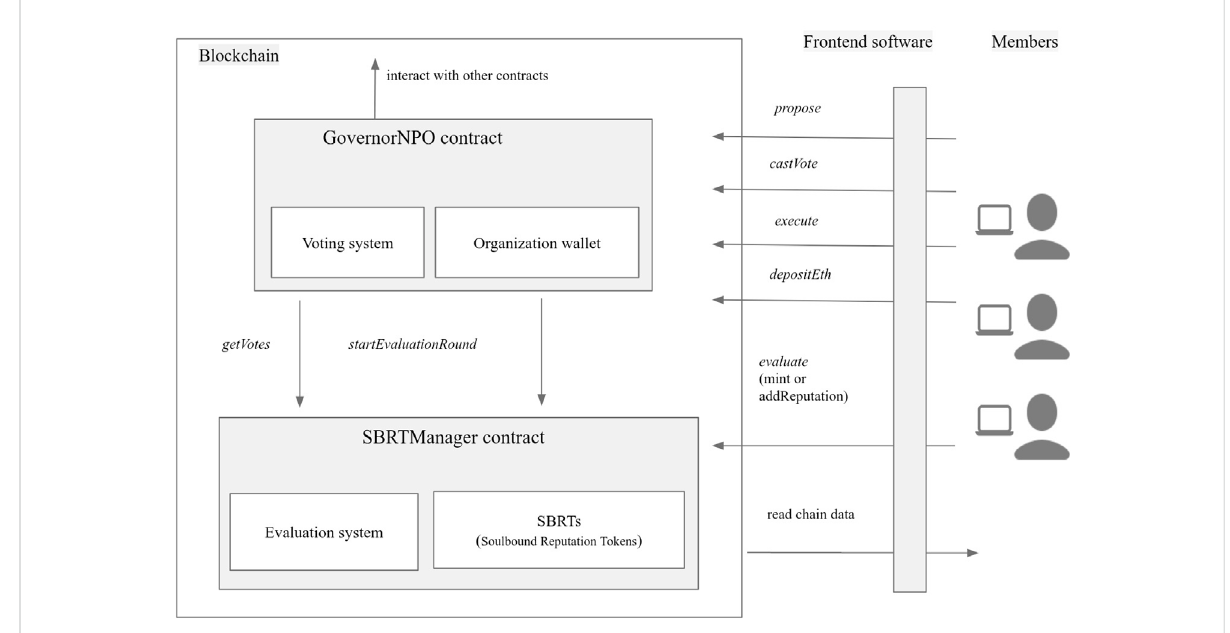
FIGURE 1 The high-level architecture of the presented DAO framework for non-pro fi ts. Note that italicized words represent function names for interacting with the smart